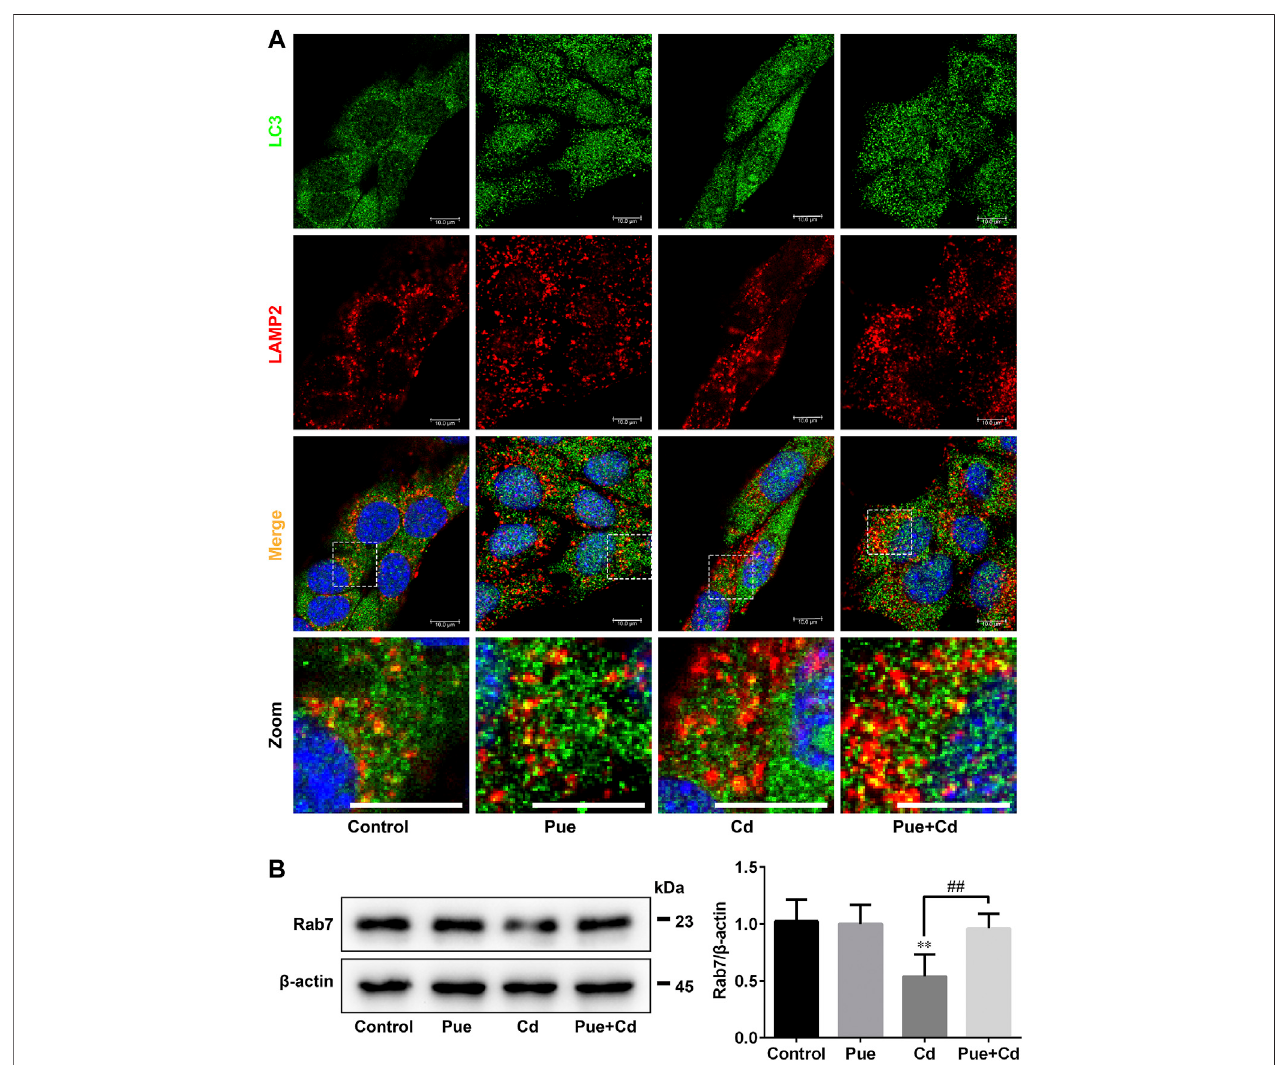
FIGURE5| Puerestoredautophagosome – lysosomefusionandtheexpression levelsofRab7inCd-exposedAML12cells.CellsweretreatedwithPueandCdfor 12 h. (A) Theco-localizationofLC3withLAMP2wasexaminedbyimmuno fl uorescencestainingtore fl ectthefusionofautophagosomesandlysosomes.Representative fl uorescence images and their partial enlarged images are shown; the yellow fl uorescence puncta indicate the fused autophagosomes and lysosomes. Scale bar (cid:2) 10 μ m. (B) The levels of Rab7 were analyzed using western blotting. Data are shown as the mean ± SD (n (cid:2) 4). Compared with the control group, ** p < 0.01. Compared with the Cd group, ## p <